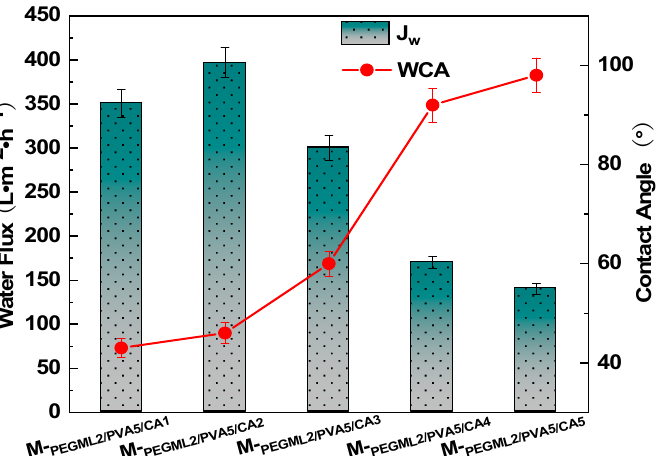
Figure 8. Water flux and water contact angle of PTFE microfiltration membranes modified with different concentrations of CA.